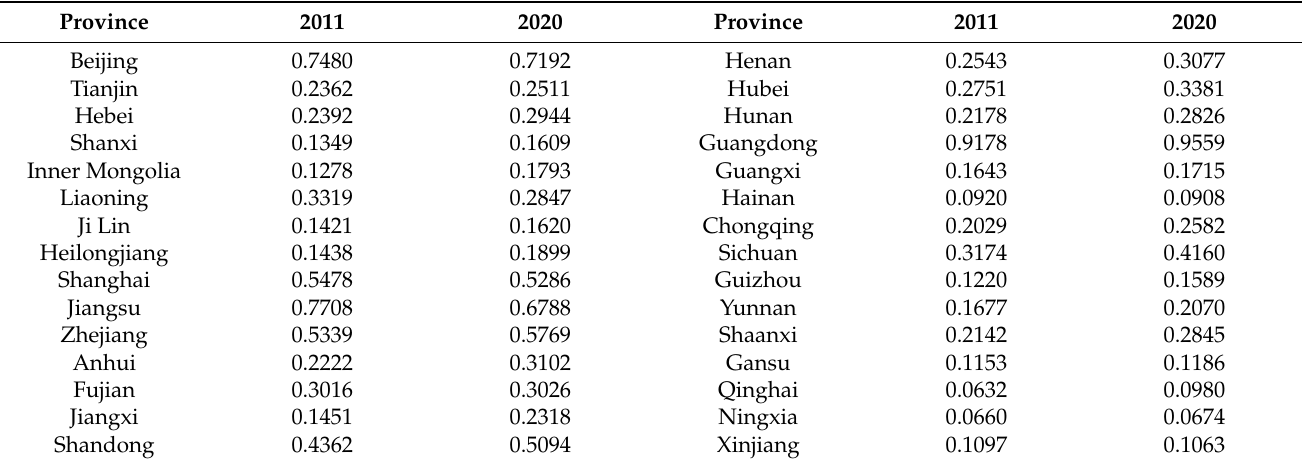
Table 4. Level of new digital